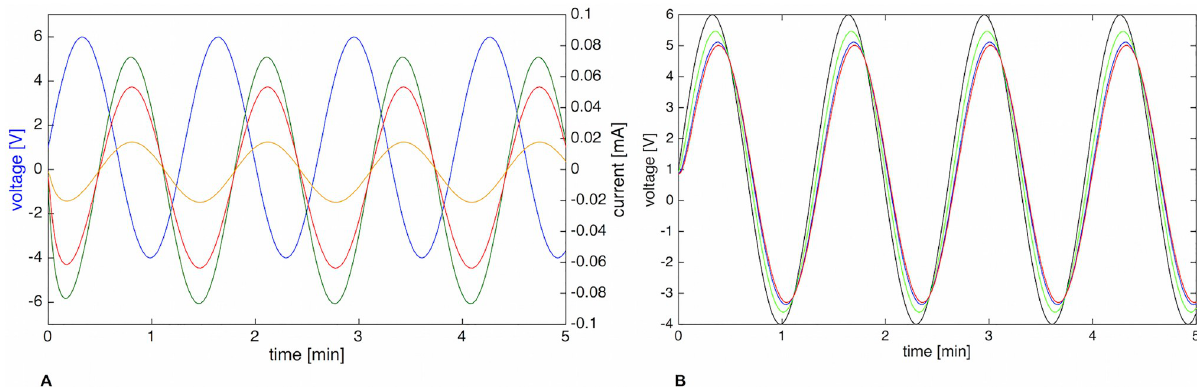
Fig 14. Input voltage and currents at three different positions; voltage at different positions. A) Input voltage (blue curve) and current through R 1 (green curve), R 3 (red curve), and R 7 (orange curve), respectively. B) Voltage measured at positions 1 (green), 2 (blue), and 3 (red). Input voltage = black curve.